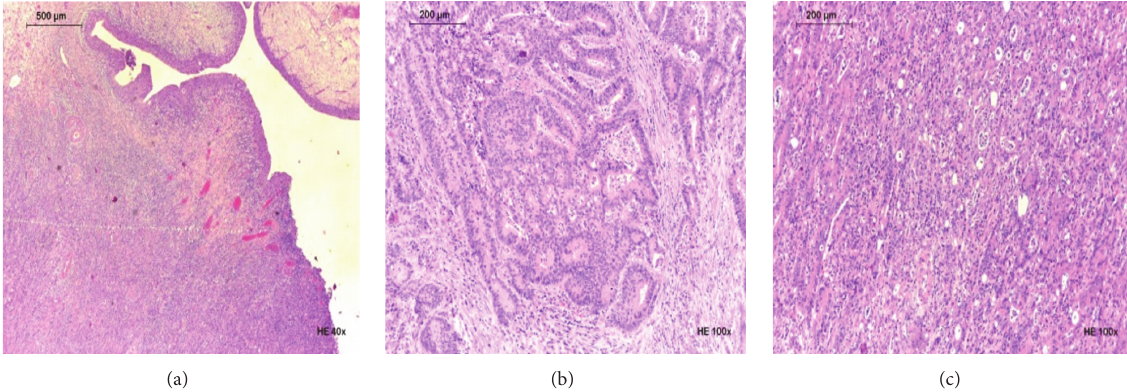
Figure 3: Histologic features of the tumor: (a) urothelium surface; (b) glandular differentiation; (c) areas of lesser differentiation.